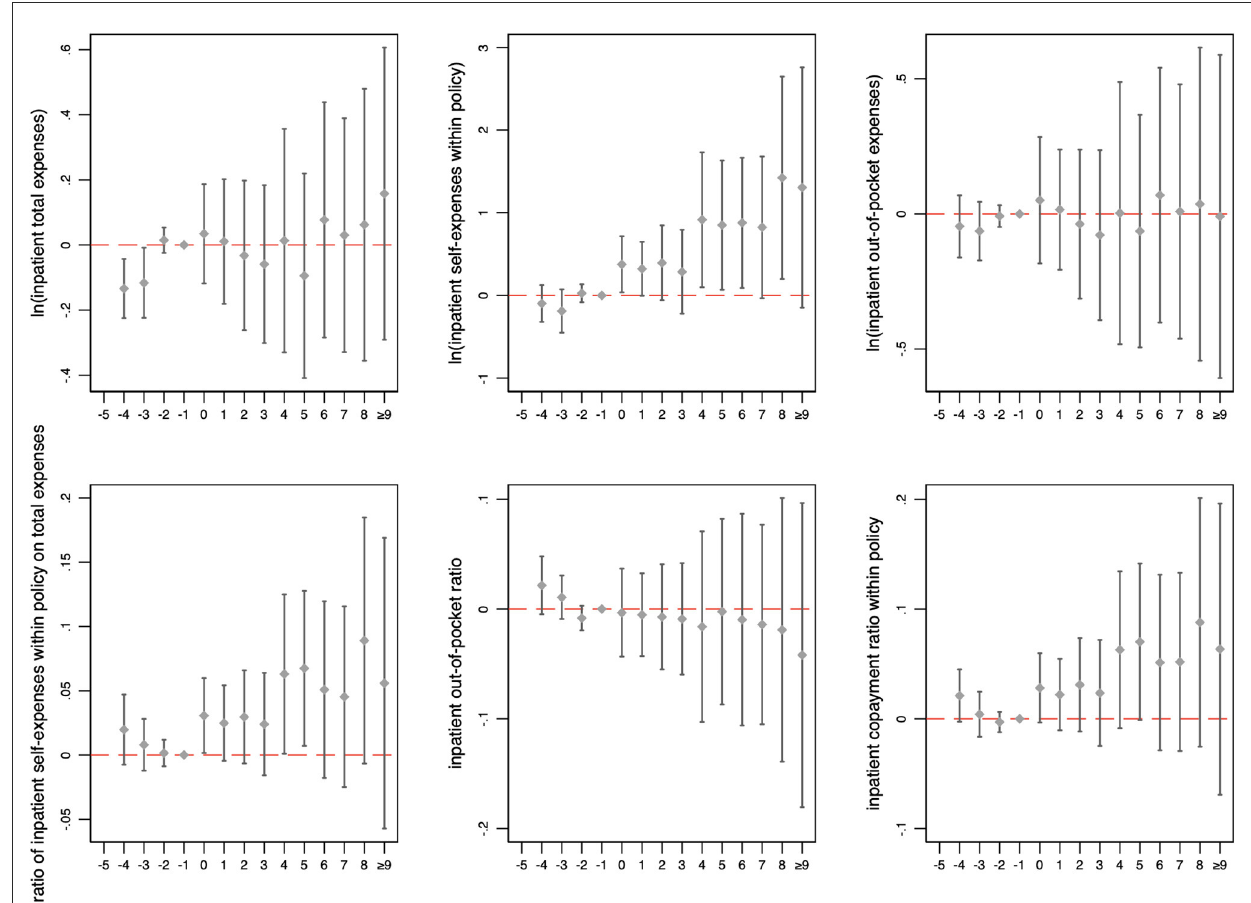
FIGURE1 Changes in inpatient medical expenses and cost-sharing ratios over time. The figure illustrates the coefficient and 90% confidence intervals generated by event study. The horizontal axis represents the number of months relative to the month of policy change implementation.